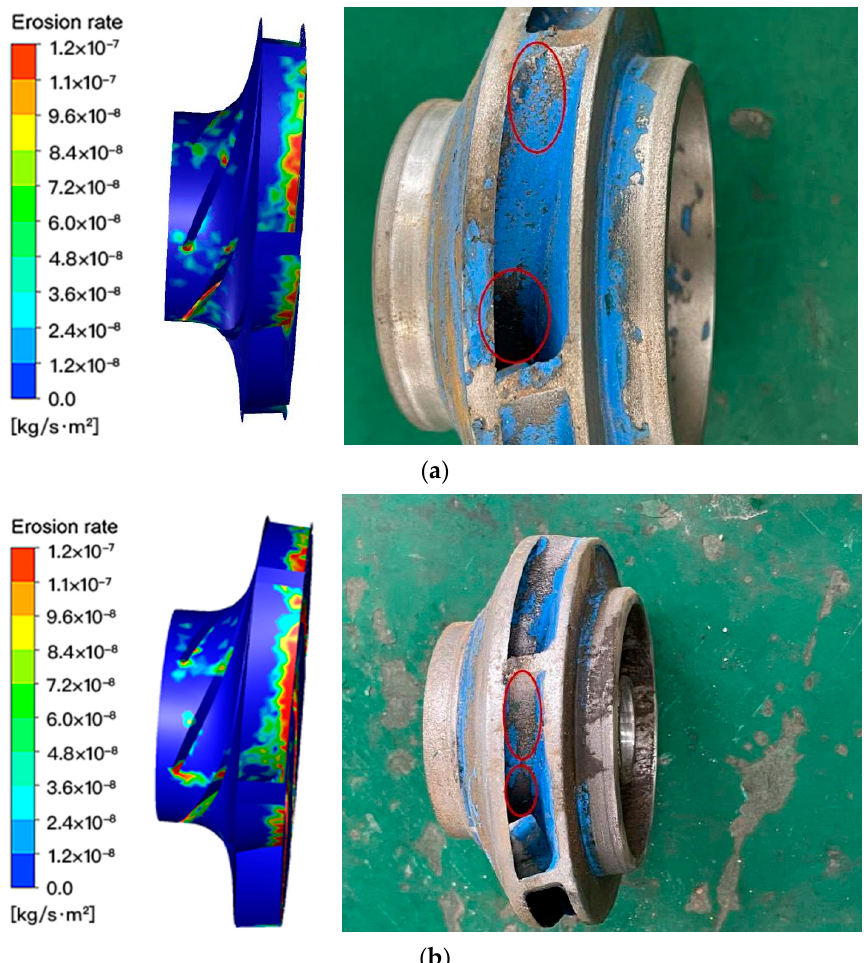
Figure 32. Comparison of numerical calculation results and test results of the erosion area under large flow conditions: ( a ) first stage impeller; ( b ) secondary impeller.